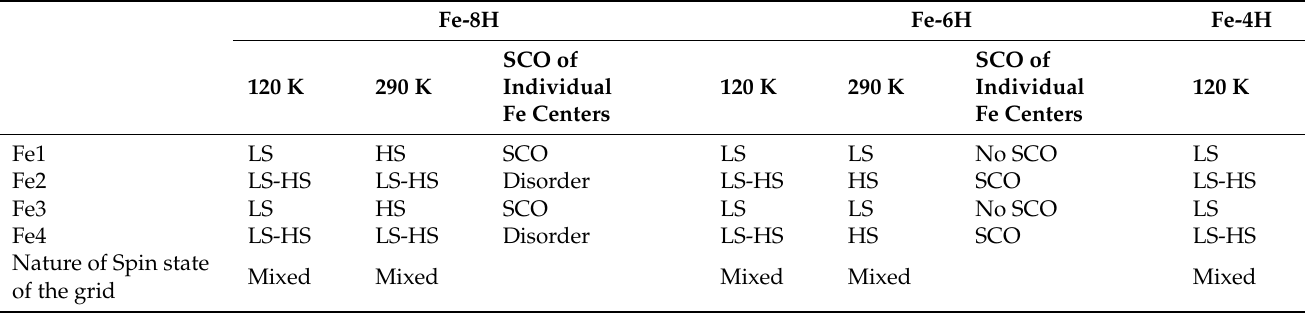
Table 1. Summary of the Fe (2 × 2) grid spin states that read from the crystallographic data at 120 and 290 K for gradual deprotonations (Fe-8H → Fe-6H → Fe-4H). Fe-8H